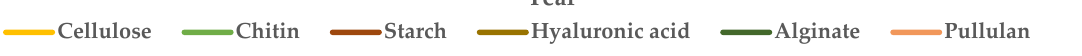
Figure 9. Publications on the usage of proteins in tissue engineering. (The number of papers published on individual proteins such as collagen, fibrin, fibroin, keratin, elastin, and gelatin is drawn based on the year and the respective total number of papers published, using search engine: www.scopus.com.) 2.5. Scaffold Fabrication Techniques Usually, the tissue comprises repeated 3D units such as islets that act as a base for coordinating multicellular processes, maintaining mechanical properties, and integrating various organs through the circulation process. Hence, while designing the scaffold for